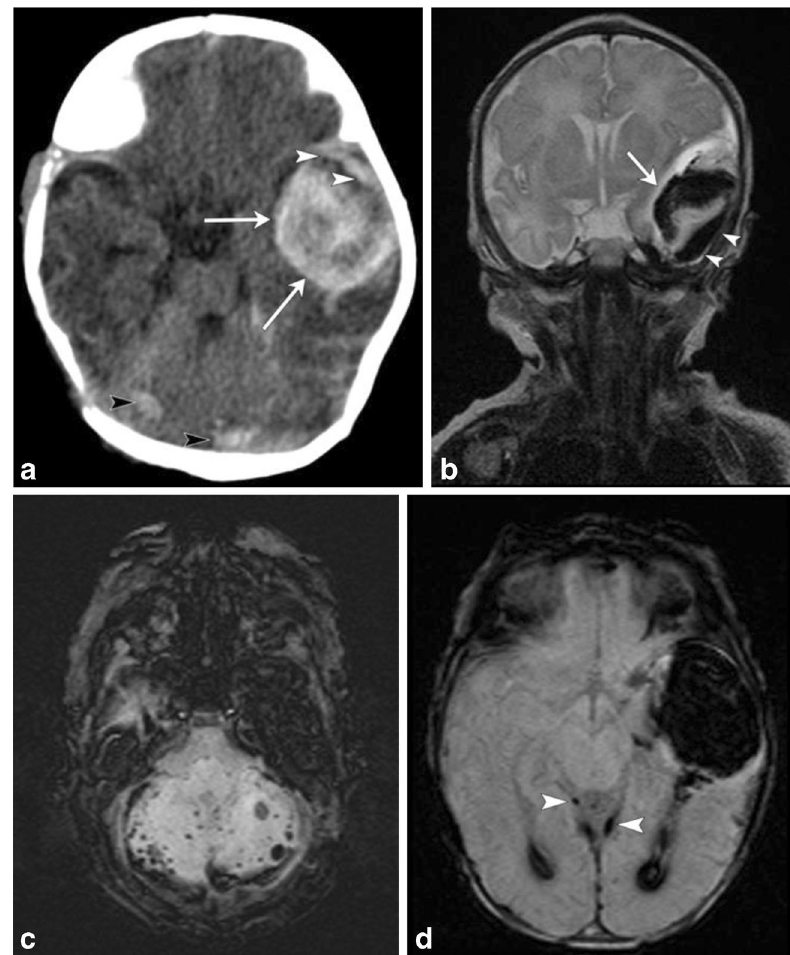
Fig. 10 Extraaxial, intraventricular and parenchymal hemorrhages in 3-day-old female post-complicated vaginal delivery presenting with seizures Axial non-contrast head CT (a) and coronal T2 MR image (b) show a large left temporal parenchymal hemorrhage (arrows), with an overlying small subdural hemorrhage (white arrowheads). Small foci of subarachnoid hemorrhage noted along the posterior fossa (white arrowheads on a), with susceptibility artifact on axial susceptibility-weighted image (SWI) (c). Axial SWI MR image (d) through the left temporal hemorrhage also demonstrates blood products within occipital horns of bilateral lateral ventricles and trace subdural hemorrhage along the tentorium (white arrowheads). Follow-up MR at 3 months (not shown) did not demonstrate